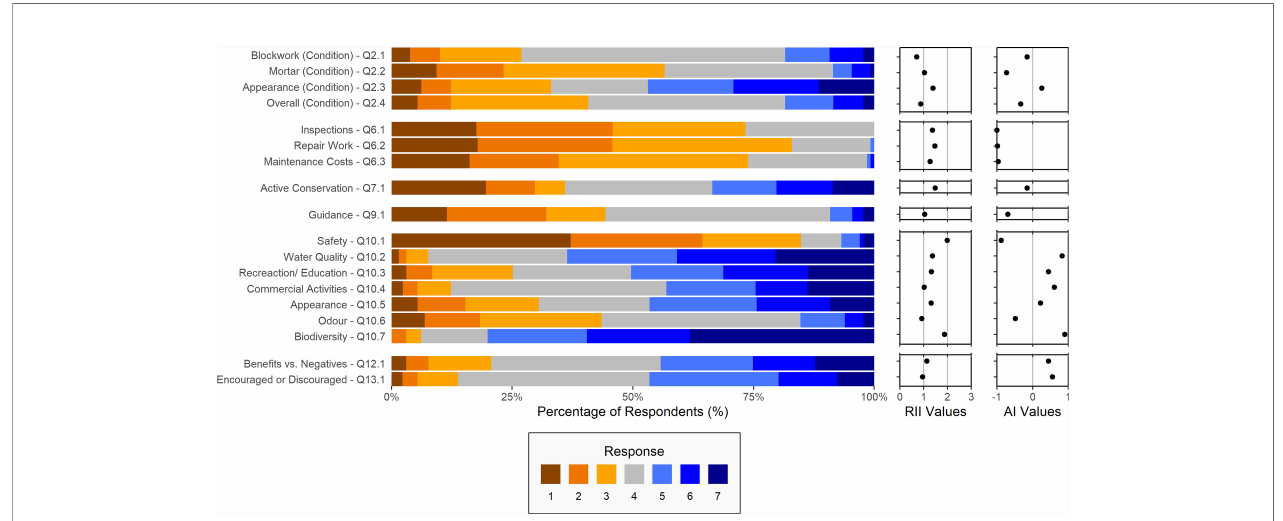
FIGURE 1 | Responses to scalar questions in the questionnaire as a percentage of total respondents with their corresponding RII and AI values. See Table 1 for Question number and